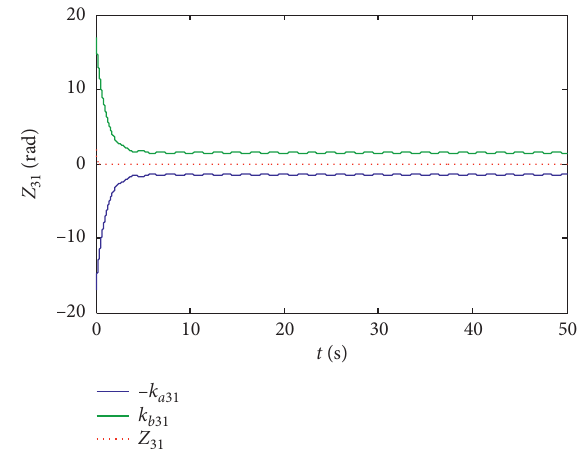
Figure 23: Constraint effect of Z